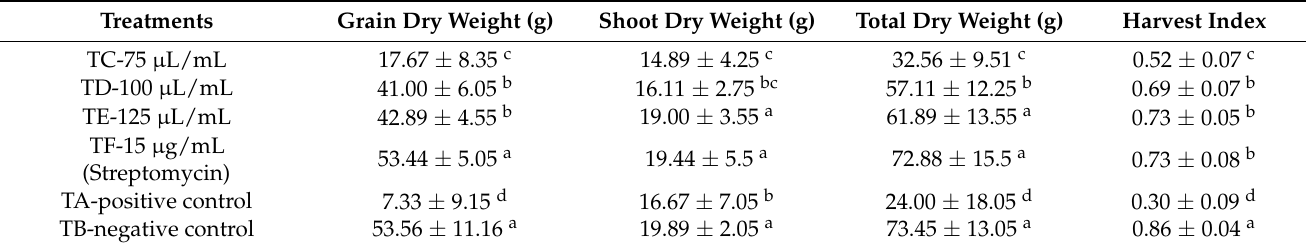
Table 3. Effect of developed nanobactericides application on yield components and harvest index of rice plant after being challenged with bacterial leaf blight disease under glasshouse trial.